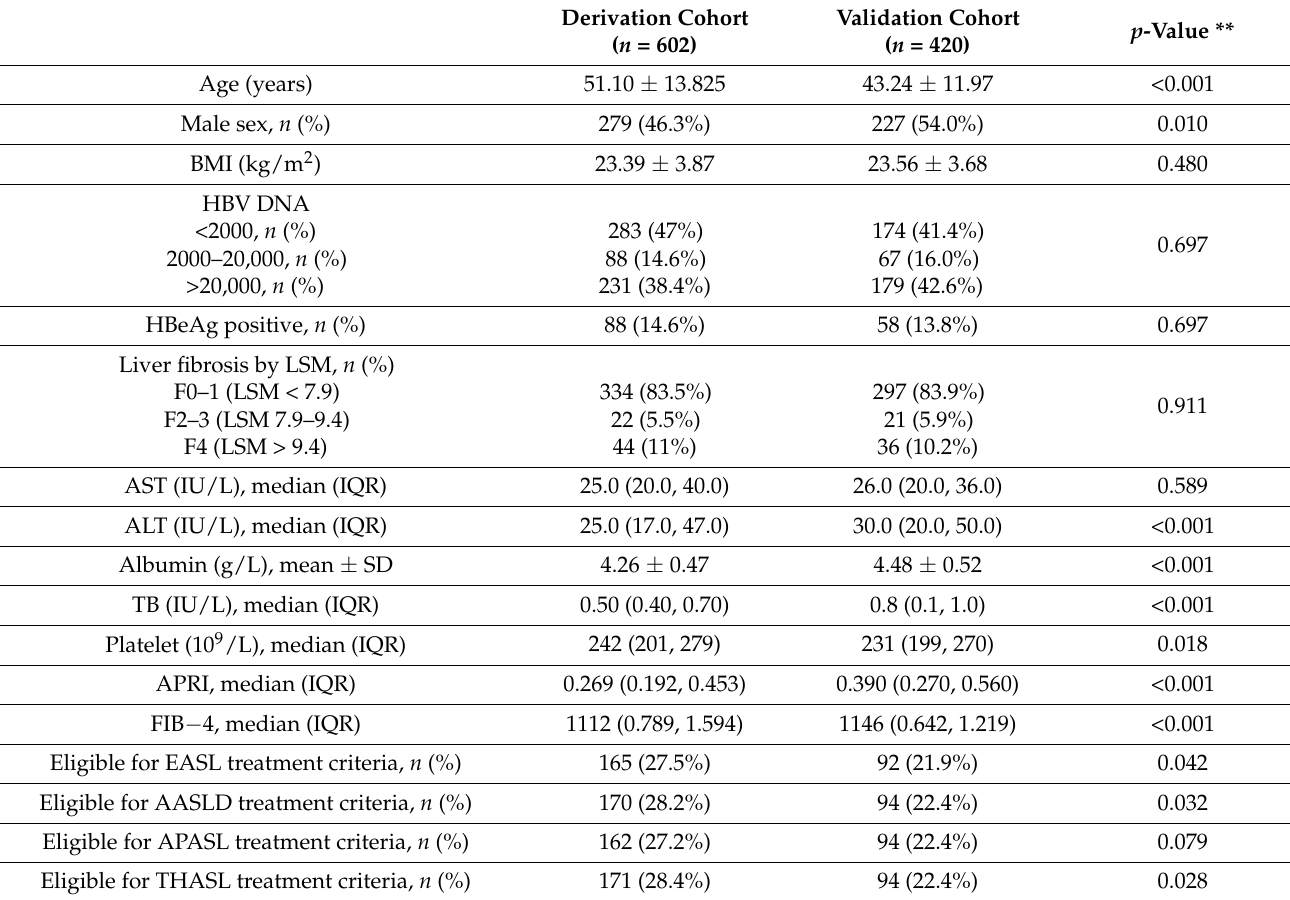
Table 1. Characteristics of study participants in the derivation cohort ( n = 602) and validation cohort ( n = 420). Derivation Cohort ( n =